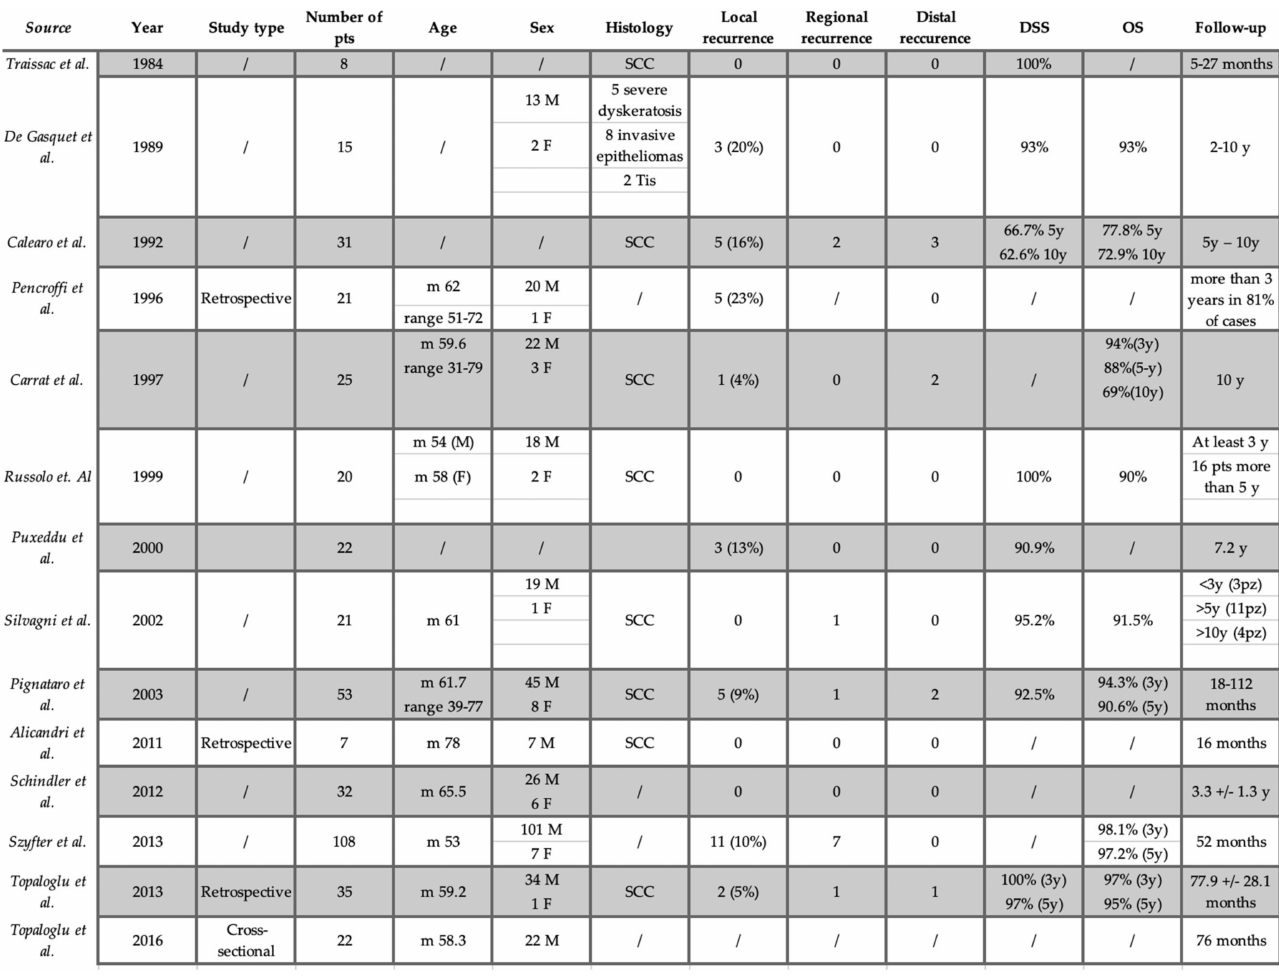
Figure 2. Oncological outcomes. M: male; F: female; y: year; pts: patients; m: median; OS: overall survival; DSS: disease-specific survival; SCC: squamous cell